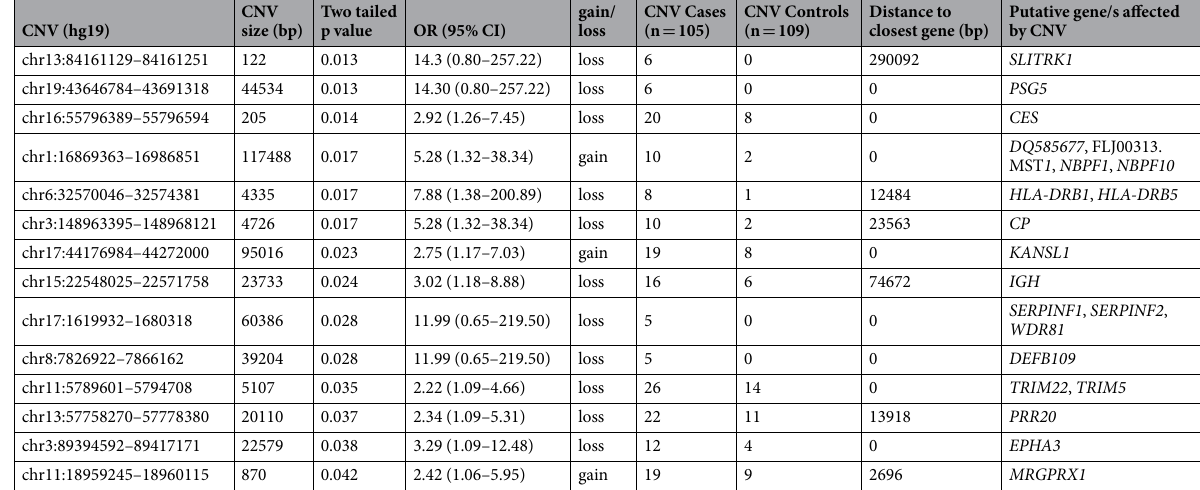
Table 1. List of top-ranked CNVs associated with CHD in 22q11.2DS patients. A summary of top-ranked CNVs associated with CHD is shown.